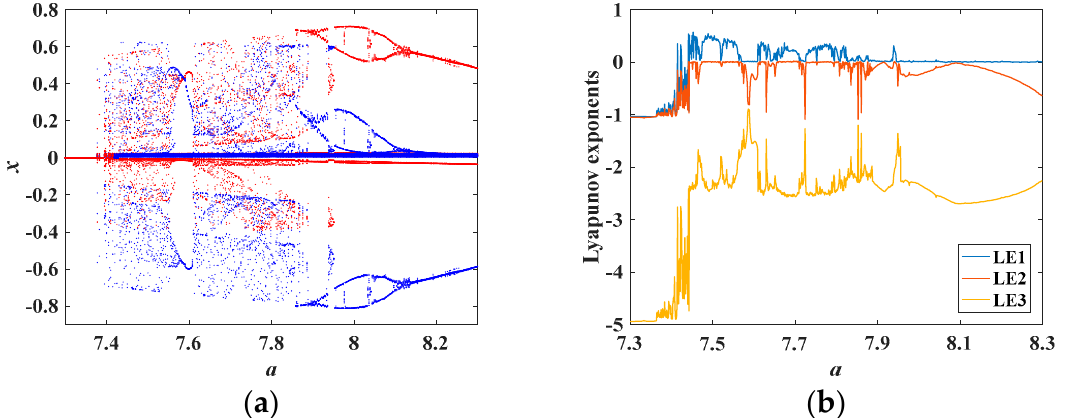
Figure 11. Dynamics of the system with the varying parameter a : ( a ) coexisting bifurcation diagram; ( b ) Lyapunov exponents.